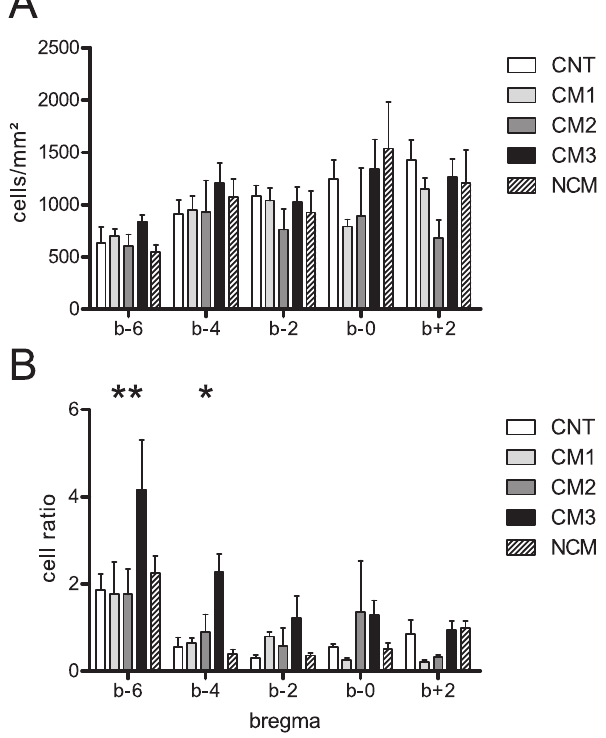
Figure 4. Stereological analysis of the number of Nogo-A positive cells per mm 2 (A) and the ratio of Nogo-A positive cells per mm 2 with intense labeling in relation to mildly labeled cells (B) in defined regions of the brain (bregma + 2, 0, -2, -4, -6 mm). The total amount of parenchymal cells positive for Nogo-A did not differ significantly between the studied groups (A). In the brain stem animals with severe CM showed a significantly higher number of neurons and oligodendrocytes with intense Nogo-A labeling (B). **, p , 0.001 for the comparison CM3 vs. CM2, CM1, CNT and p , 0.01 for the comparison CM3 vs. NCM; *, p , 0.01 for the comparison CM3 vs. NCM and p , 0.05 for the comparison CM3 vs. CM1, CNT. Mean and SEM are